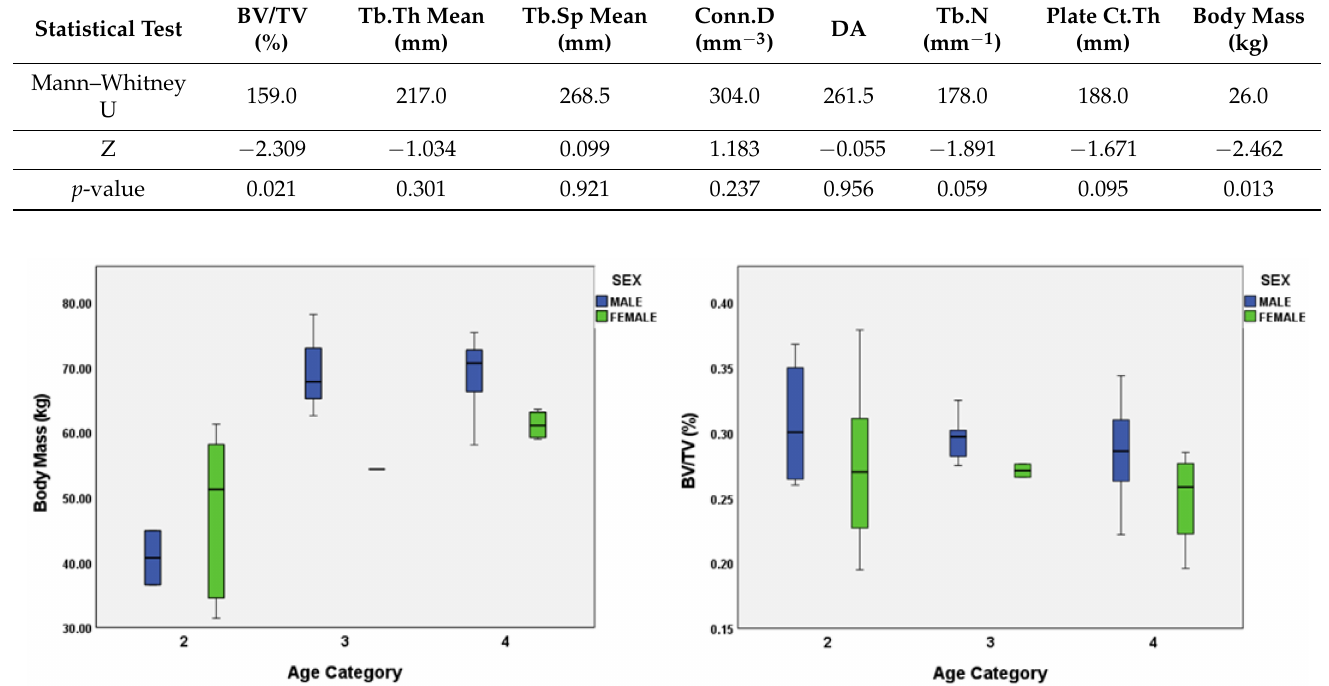
Figure 6. Body mass and bone volume fraction sex differences across